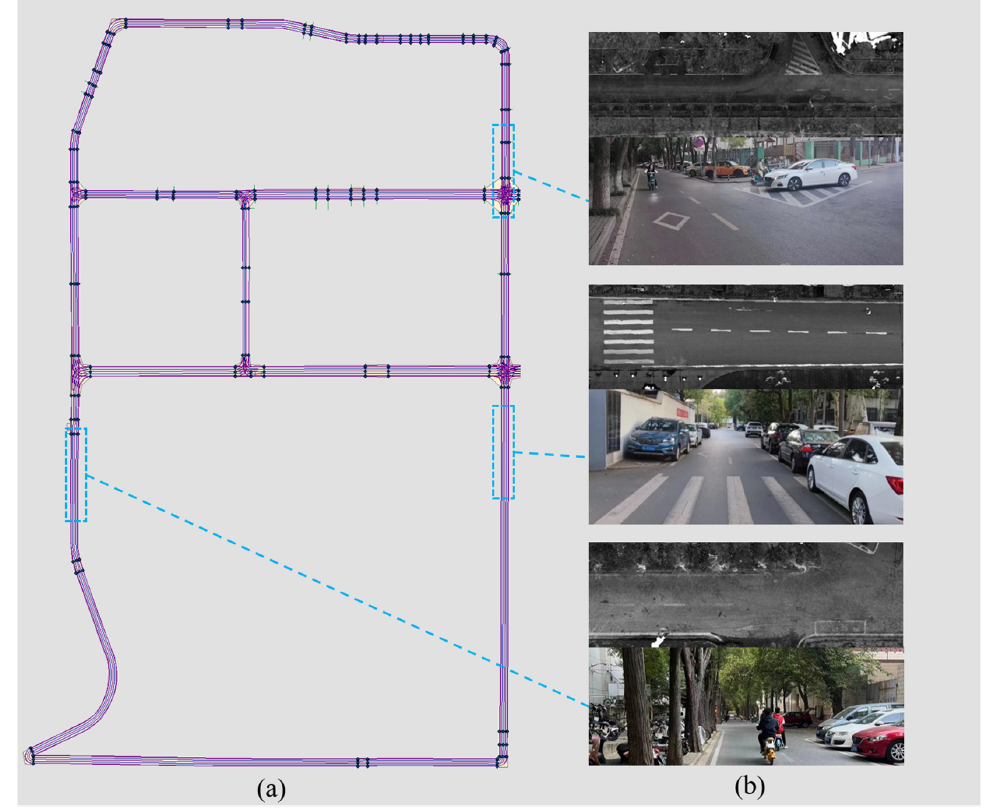
Figure 1. Examples of Wuhan University campus scenes(a,